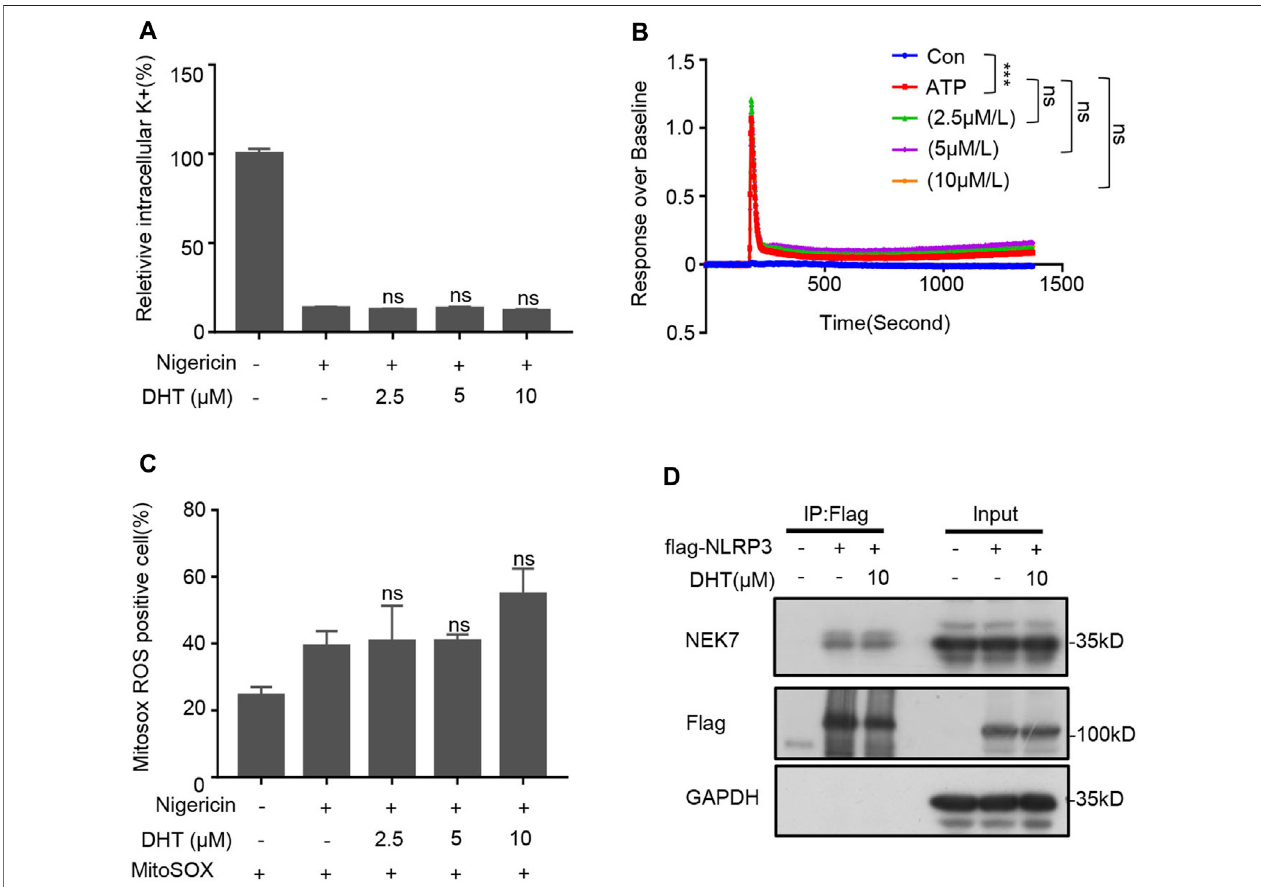
FIGURE4| DHThasnoeffectonupstreamsignalingeventsofNLRP3in fl ammasomeactivationandNLRP3 – NEK7interaction. (A) Quali fi cationofpotassiumef fl uxinLPS- primed BMDMs exposed to various doses of DHT (2.5, 5, 10 μ M) and then stimulated with nigericin. (B) ATP-induced Ca 2+ fl ux in LPS-induced BMDMs treated with or without DHT was measured using a FLIPR Tetra system. (C) LPS-primed BMDMs treated with DHT and then stimulated with nigericin were detected by staining with MitoSox. The percentage of ROS-positive cells was obtained by fl ow cytometry. (D) HEK-293T cells were transfected with Flag-NLRP3, and DHT (10 μ M) was added at 18 h post transfection.Immunoprecipitationwasperformedwithanti-Flagaf fi nitygel-agarosebeads,followedbyWesternblotanalysis.GAPDHwasusedasthelysateloadingcontrol.Data are shown as mean ± SEM from three biological replicates. One-way ANOVA was used to analyze the data. * p < 0.05, ** p < 0.01, *** p < 0.001, NS: not signi fi cant.